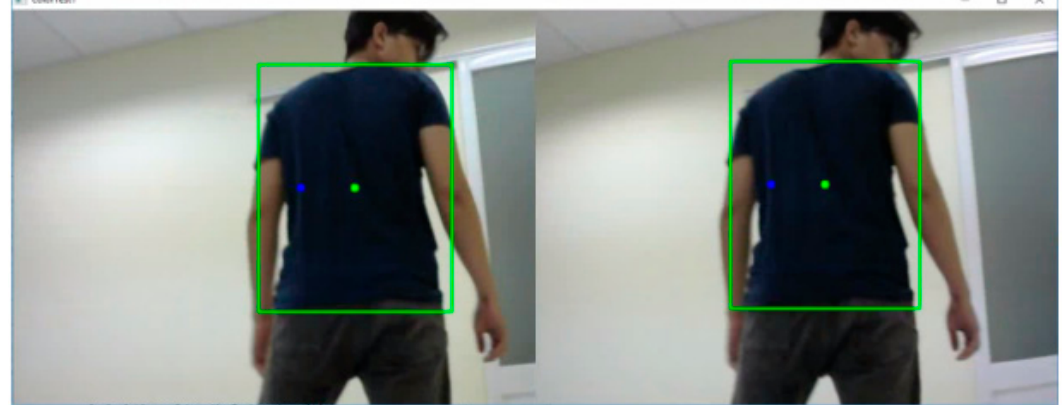
Figure 13. Image after threshold in HSV.